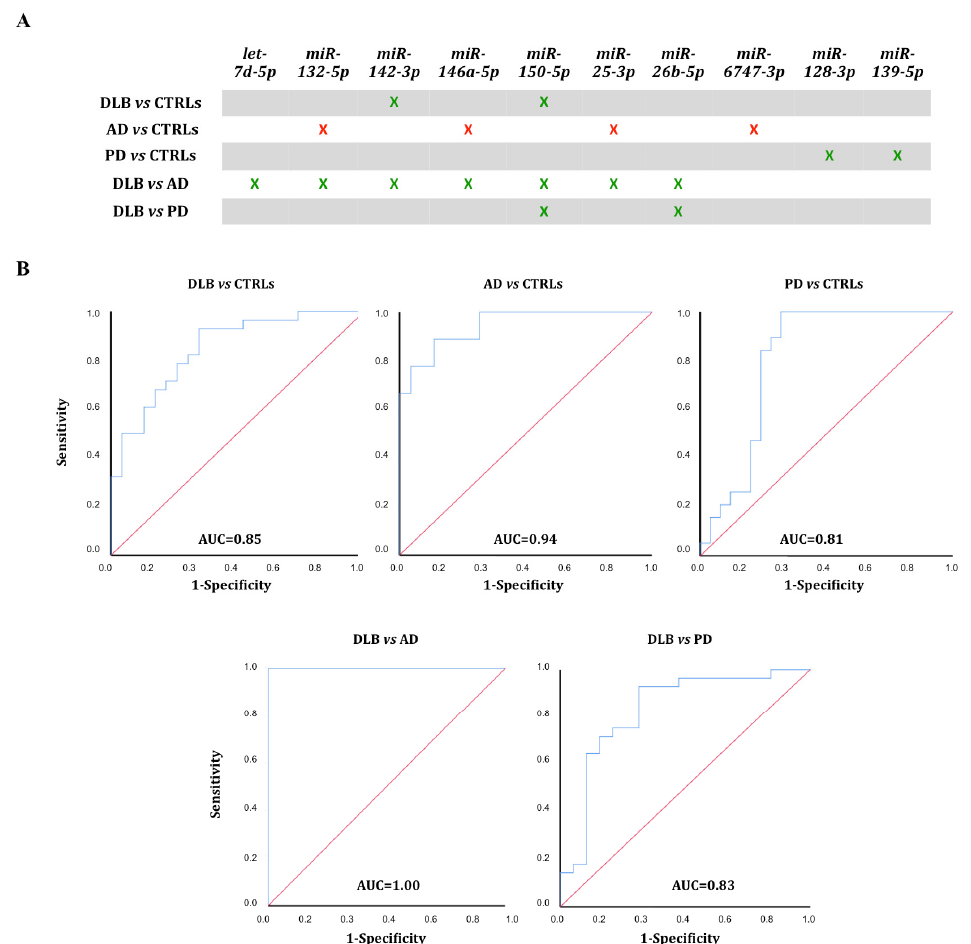
Figure 5. Diagnostic outcome for the five miRNA-sets. ( A ) Significantly different miRNAs ( p < 0.01) were clustered into 5 different sets. Diminished expression—green, increased expression—red. ( B ) ROC curves were calculated for miRNAs with differential expression ( p < 0.01) between two cohorts.